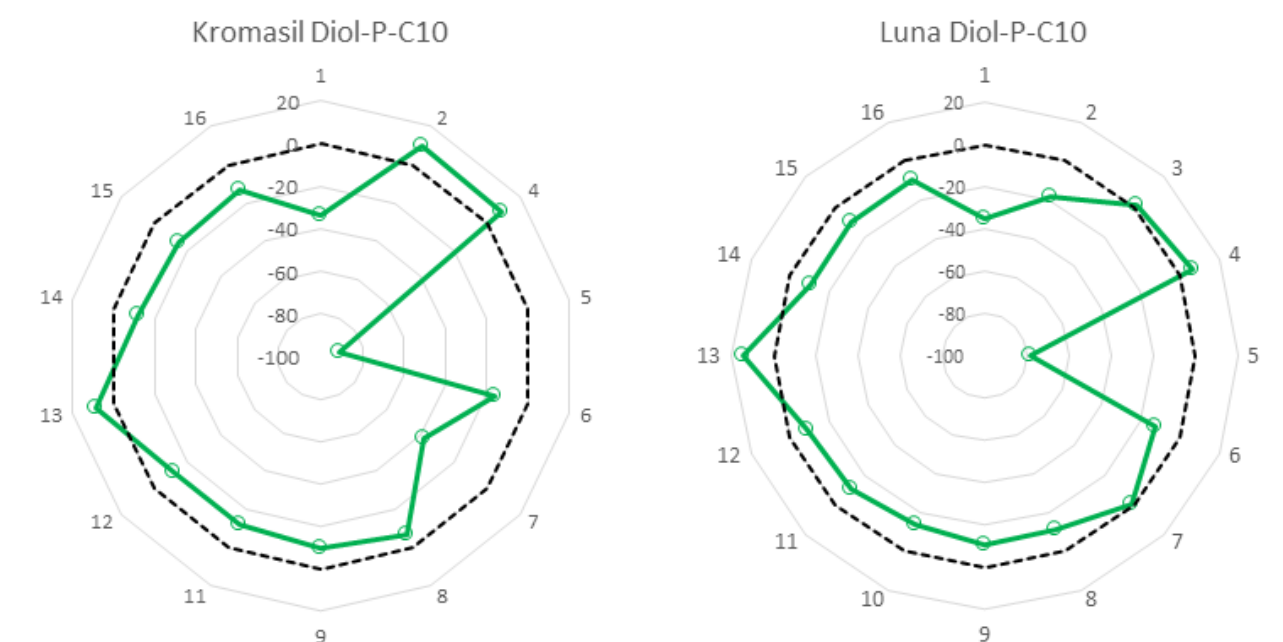
Figure 2. Comparison of zeta potential for stationary phases synthesized on a different support.